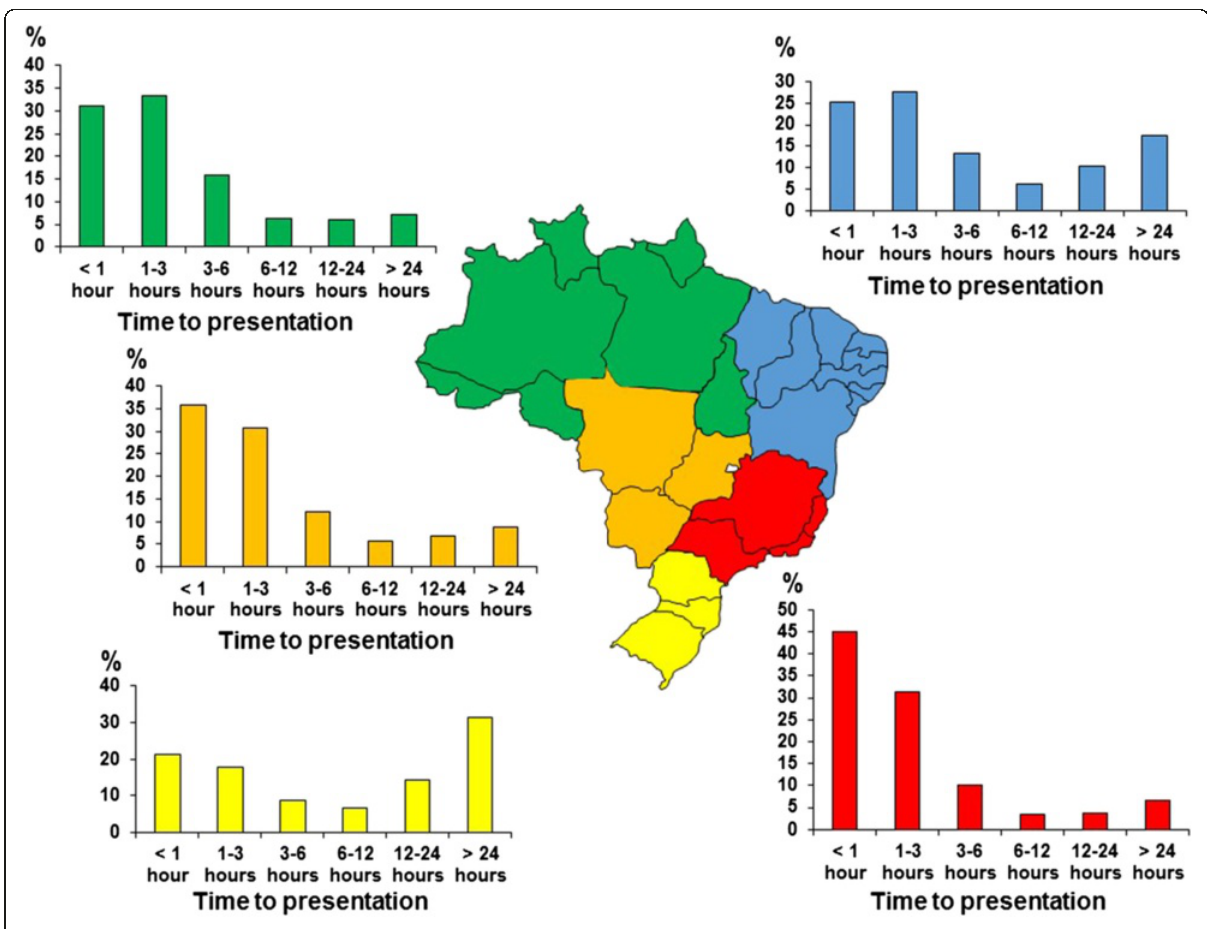
Fig. 9 Time to presentation at the hospital after spider bites according to the